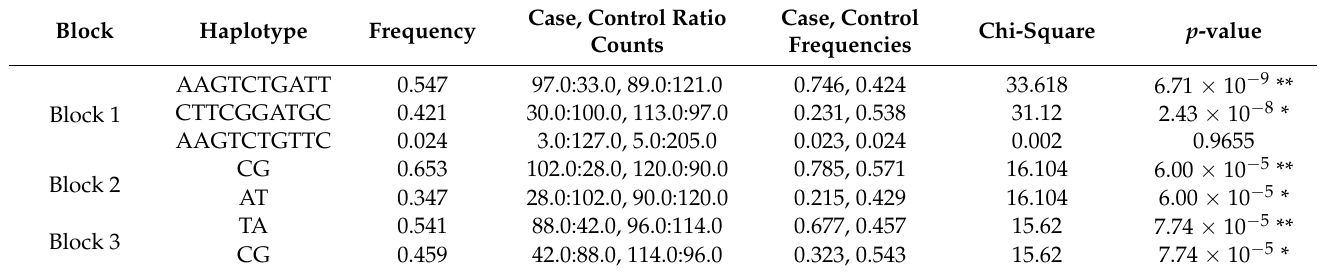
Table 2. Significant haplotypes of SNPs on chromosome 6 in autistic